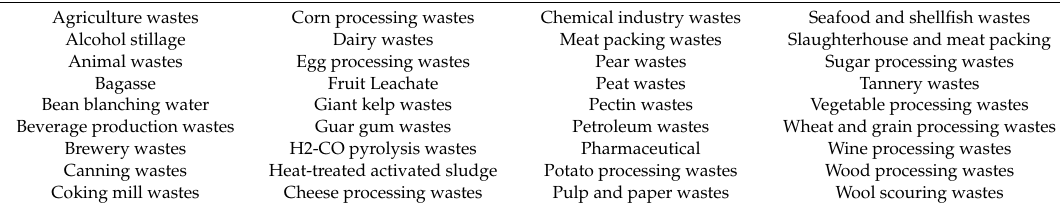
Table 3. Industrial wastes amenable to anaerobic